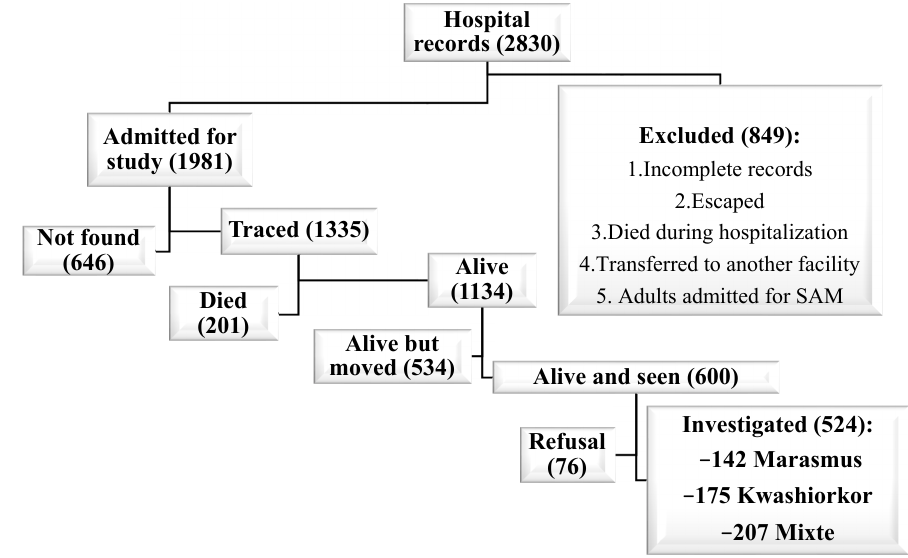
Figure 1. Recruitment of exposed group.